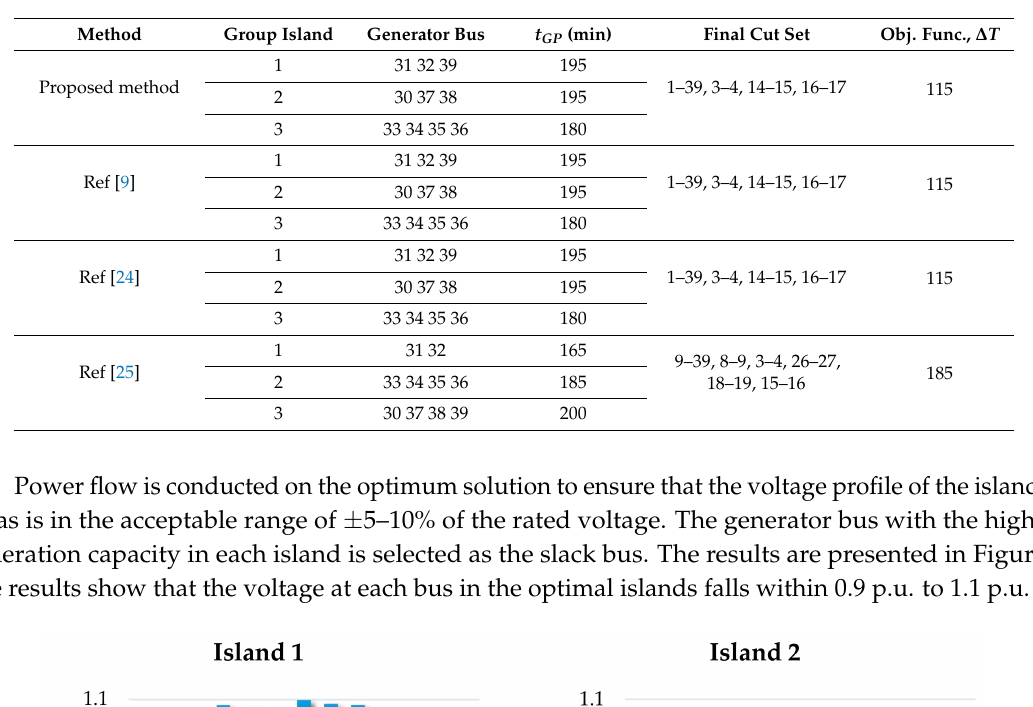
Table 4. Methods for the ‘total island’ network reenergizing approach.